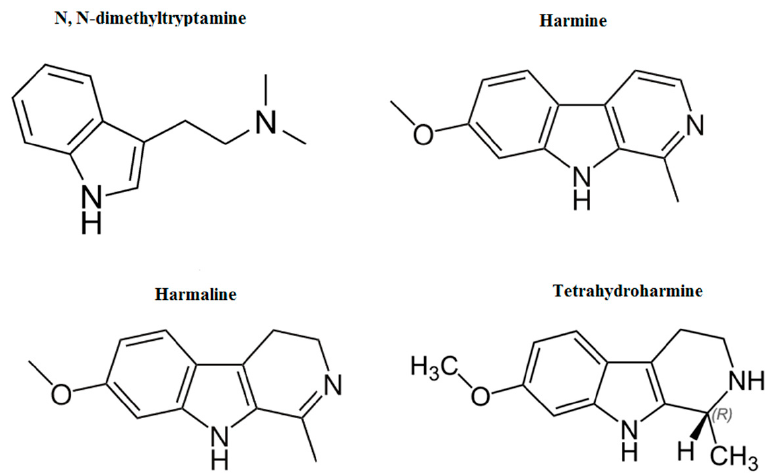
Figure 1. Chemical structures of N,N-dimethyltryptamine (DMT), tetrahydroharmine (THH), harmaline (HML), and harmine